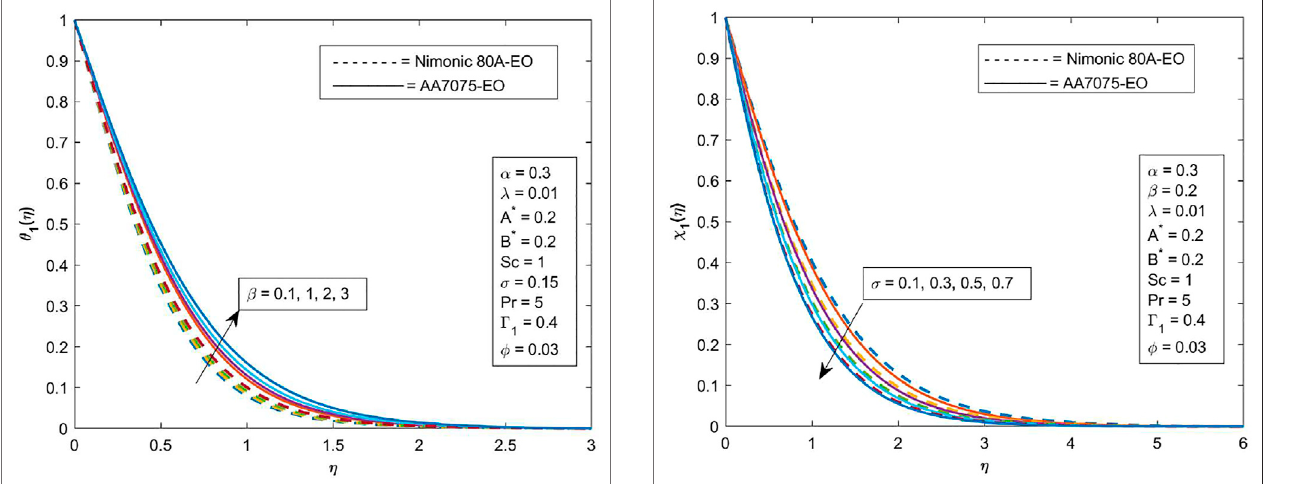
FIGURE 7 | Provocation of σ on χ 1 .